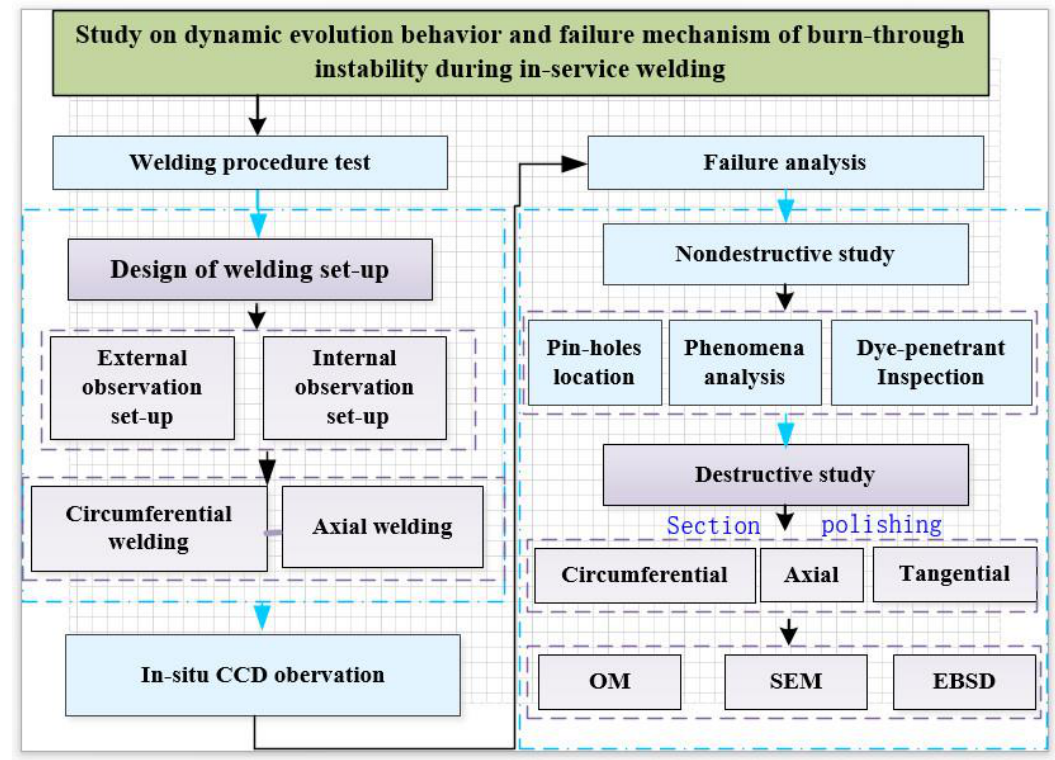
Figure 2. Flow chart of the experimental procedure. Table 3. Circumferential in-service welding observed with external observation set-up.